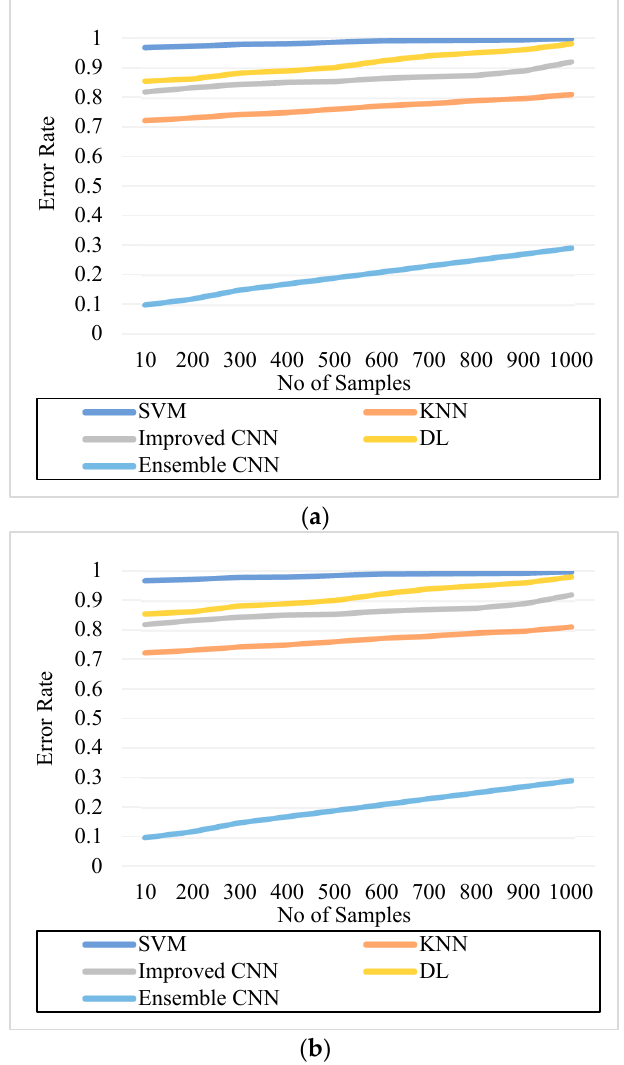
Figure 10. Error Rate. ( a ) IDRiR and ( b ) Messidor.